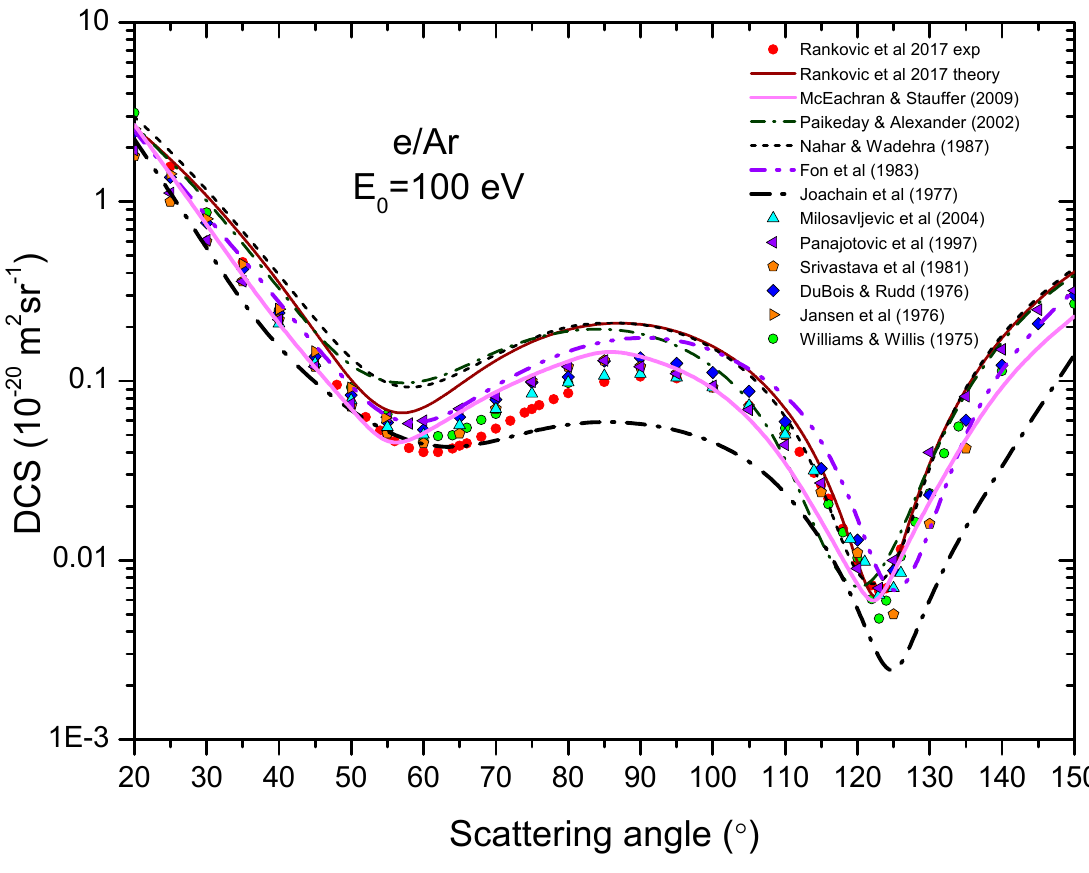
Figure 4. DCS for elastic electron scattering by argon atom at 100 eV impact energy. The data symbols used correspond to: (red circles) , Rankovic et al. [49] experiment; (dark red full line), Rankovic et al. [49] theory; (magenta solid line), McEachran and Stauffer [50]; (olive dash dot line), Paikeday and Alexander [51]; (dotted line), Nahar and Wadehra [52]; (violet dash dot dot line), Fon et al. [53]; (cyan dash dot line), McCarthy et al. [54]; (dashed line), Joachain et al. [55]; (cyan up triangles), Milosavljevi´c et al. [56]; (violet left triangle), Panajotovi´c et al. [57]; (orange pentagons), Srivastava et al. [58]; (blue diamond), DuBois and Rudd [59]; (orange right triangles), Jansen et al. [60]; (green circles), Williams and Willis [61].